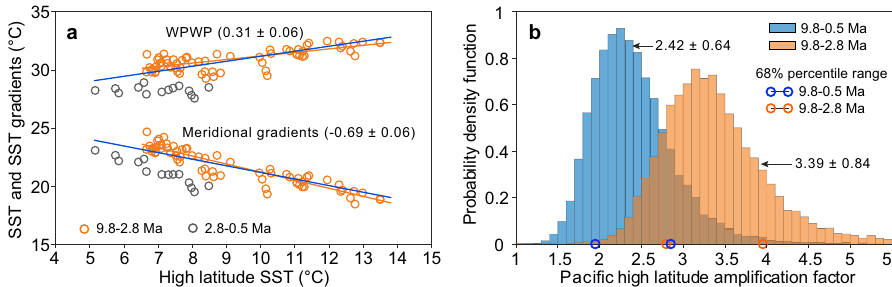
Fig. 4 | Paci fi c high latitude ampli fi cation of the ice-free (10 – 2.8Ma) Northern Hemisphere vs. the past 10Myr. a Sea surface temperature (SST) changes of the WesternPaci fi cWarmPool (WPWP)relative to highlatitudes. Meridionalgradients are SST differences from the WPWP to high latitudes. Orange dots represent the datapriorto2.8Ma,whereasgraydotsrepresentthedataafter2.8Ma.Orangelines indicatelinearregressionsforthedatapriorto2.8Ma.Theregressionmethodsare thesameasthoseinFig.3andTable1.Bluelinesrepresentlinearregressionsforthe data of the entire 10Myr, identical to the black dashed lines shown in Fig. 3. The